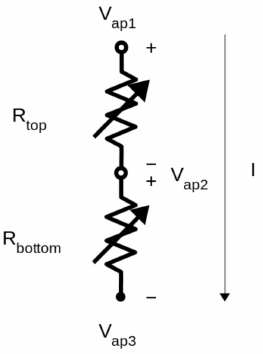
Figure 3. Serial RRAM cell for secure memory design.